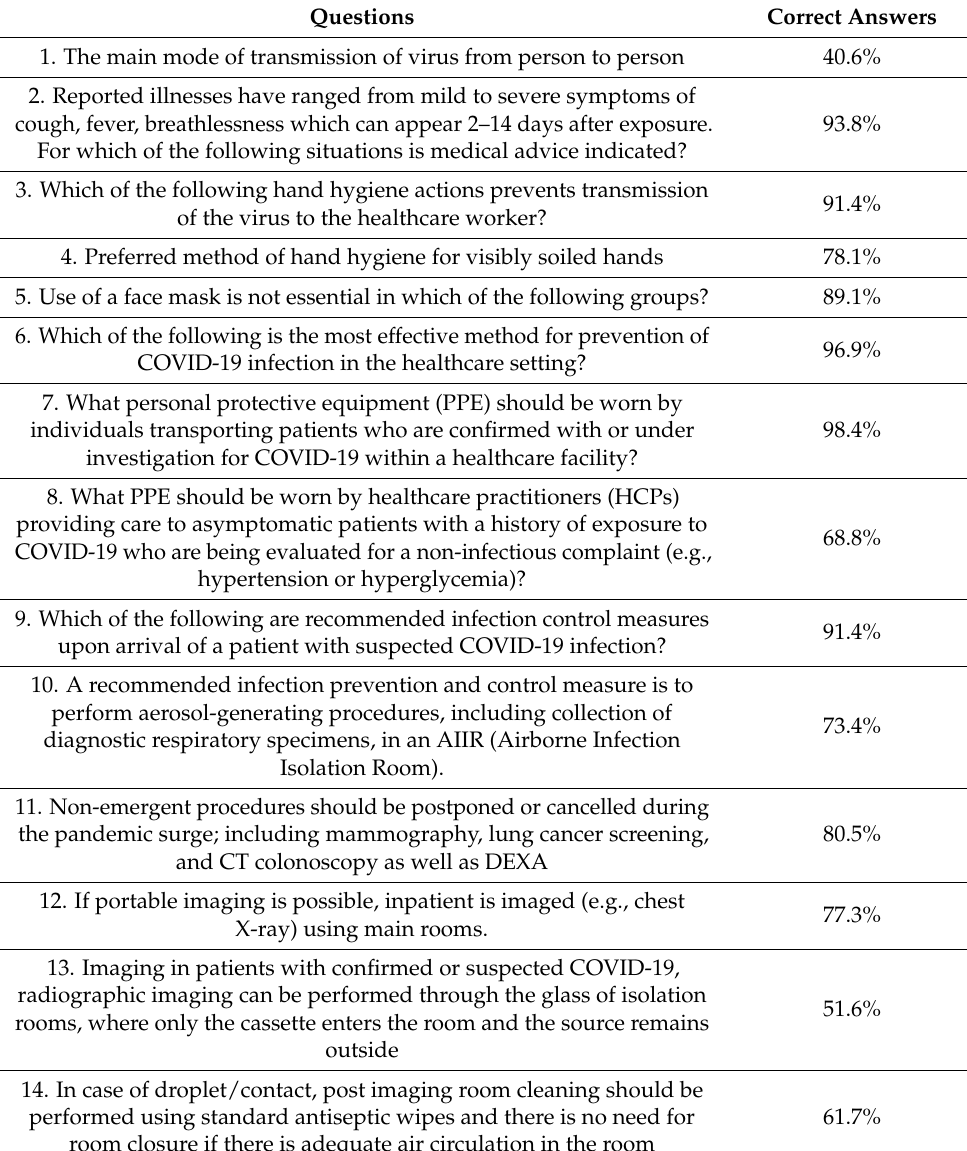
Table 2. The distribution of correct answers for all